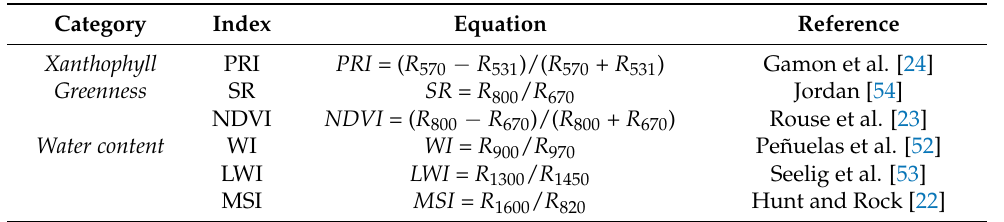
Table 1. Optical visible, near- and shortwave infrared (VNIR/SWIR) narrowband indices grouped by category: (1) xanthophyll pigments, (2) greenness and (3) water content. R is the reflectance centre wavelength of HyPlant Dual Chanel in units of